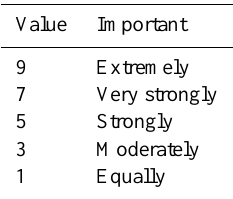
Table 4. Eigenvector